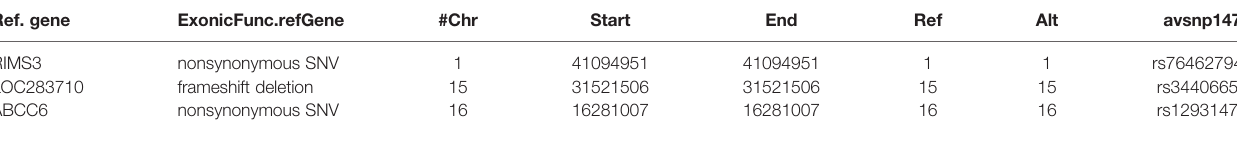
TABLE 2 | Summary of their speci fi c driven mutations existing in each tumor analyzed by NGS. Location